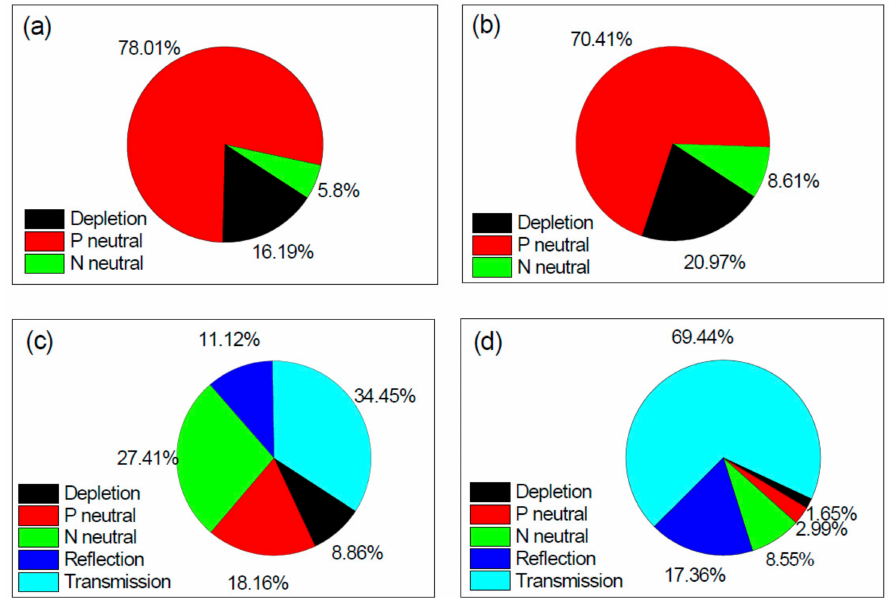
Figure 10. Simulated pie-charts of PDP components of our SPAD biased at Vex = 5.0 V. ( a ) Contribution analysis at 700 nm; ( b ) Contribution analysis at 900 nm; ( c ) Loss analysis at 700 nm; ( d ) Loss analysis at 900